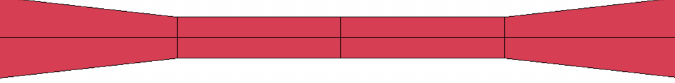
Figure 4. FE discretization of the tensile specimen.